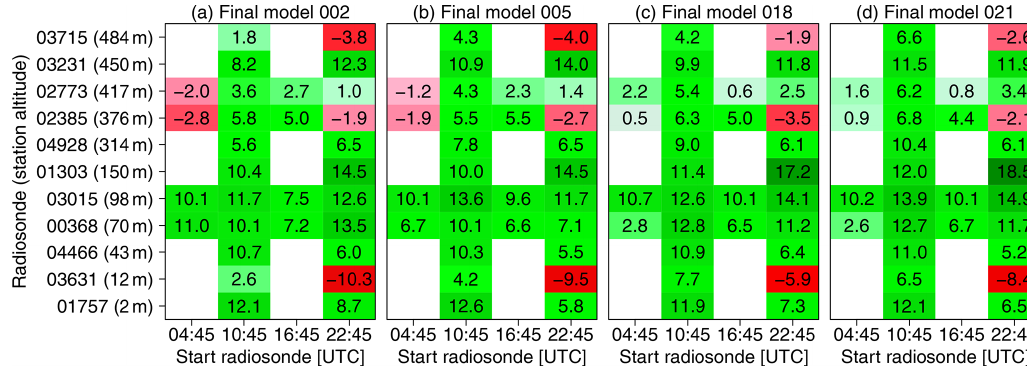
Figure 6. Improvement of RMSE (in %) of the ANNs trained over all 12 stations compared to COSMO-REA6 with (a) 2, (b) 5, (c) 18 and (d) 21 input variables. Green (red) colors indicate an improvement